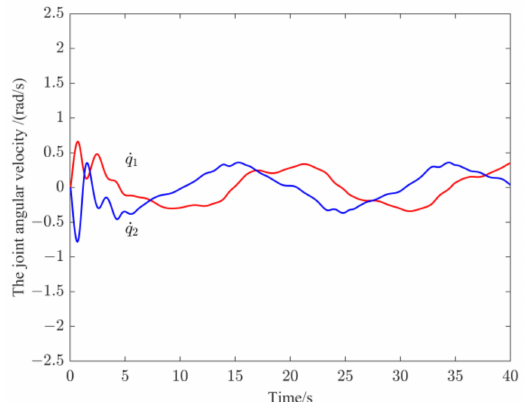
. q when u p is off. θ